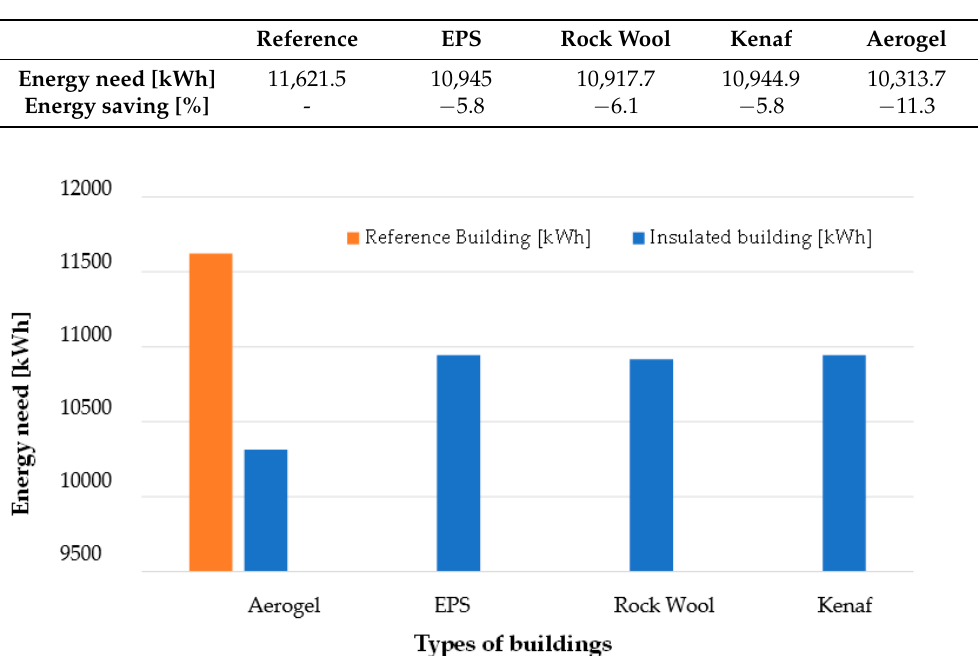
Figure 9. Energy needs of the reference building and the insulated one.